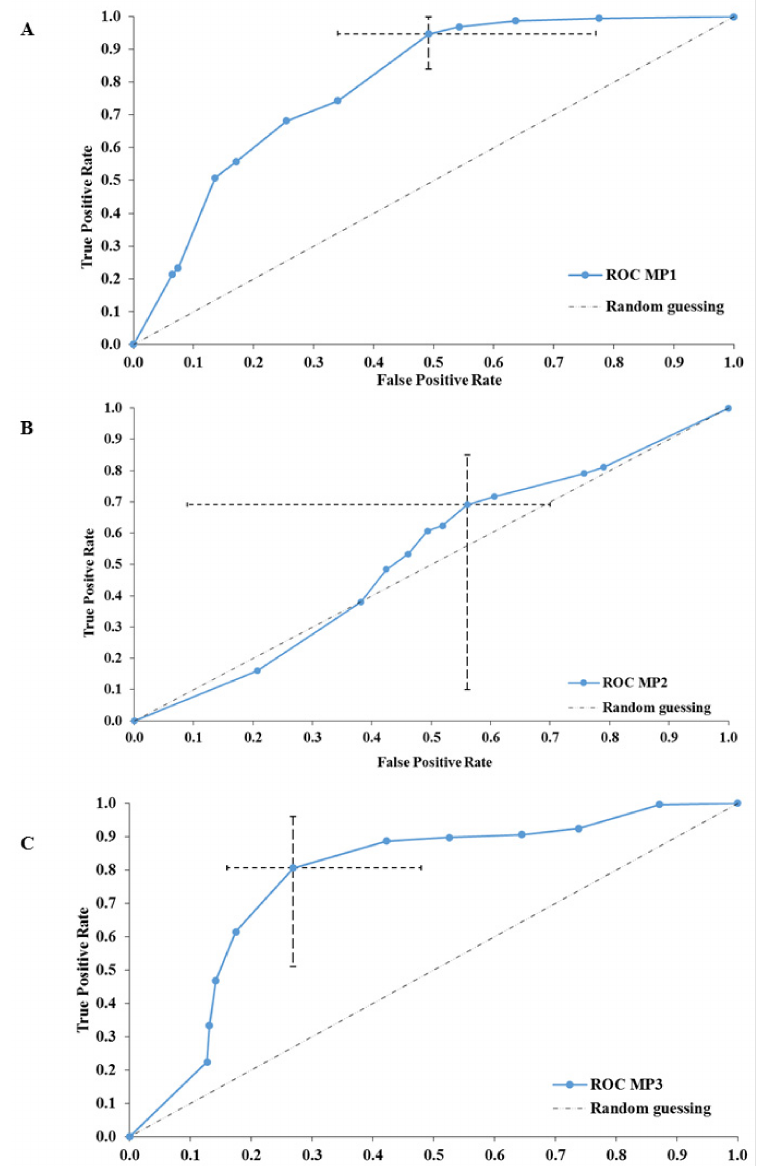
Figure 3. An overview of the model performance in three different groups between fecal metabolomes in delineation with three different groups of MP (MP1 < 30 ( A ), 30 < MP2 < 75 ( B ) and MP3 > 75 ( C )). Please note the rather uncharacteristic and hard to classify makeup of metabolomes observed in the intermediate, healthy, group ( B ). Horizontal and vertical dashed lines represent 95% confidence interval for false positive and true positive rates, respectively. The black dashed line represents model performance in case of random guessing; blue line represents training mean performance of the